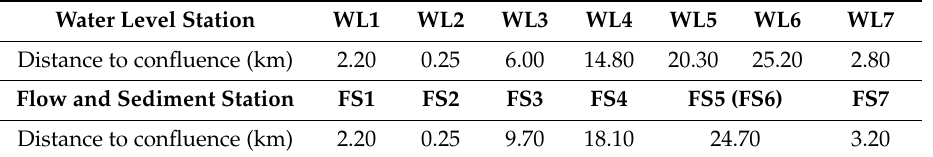
Table 1. Distance of field measurement stations to the confluence.